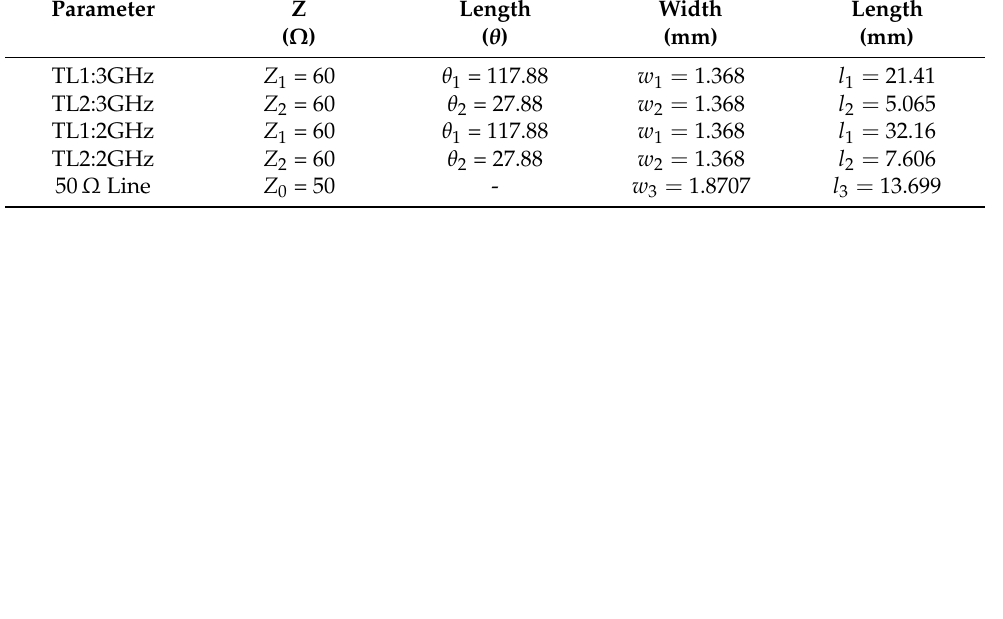
Table 2. Calculated design parameters using the proposed method ( ε r = 2.97, H = 0.76 mm, R = 36 Ω ).